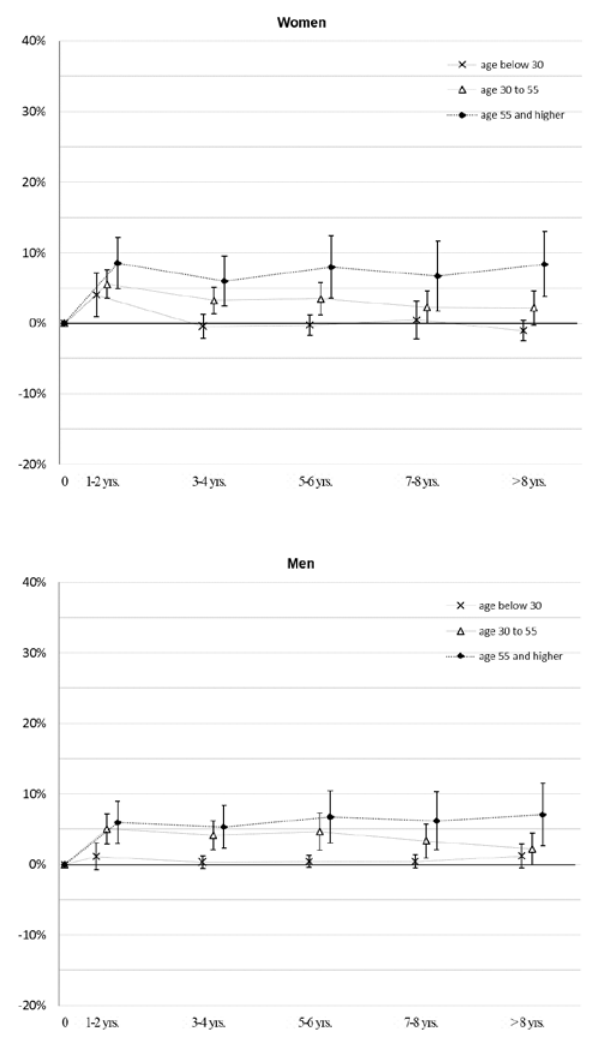
Figure 4 : Age-differences in time-effects of relationship endings on social isolation (concurrent isolation from all social spheres; linear-probability models with fixed effects, percentage points and 95%-confidence limits)